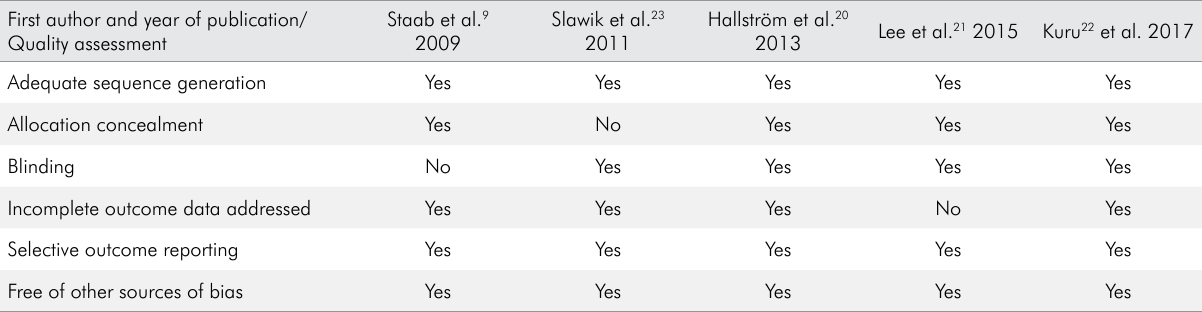
Table 3. Quality assessment of included